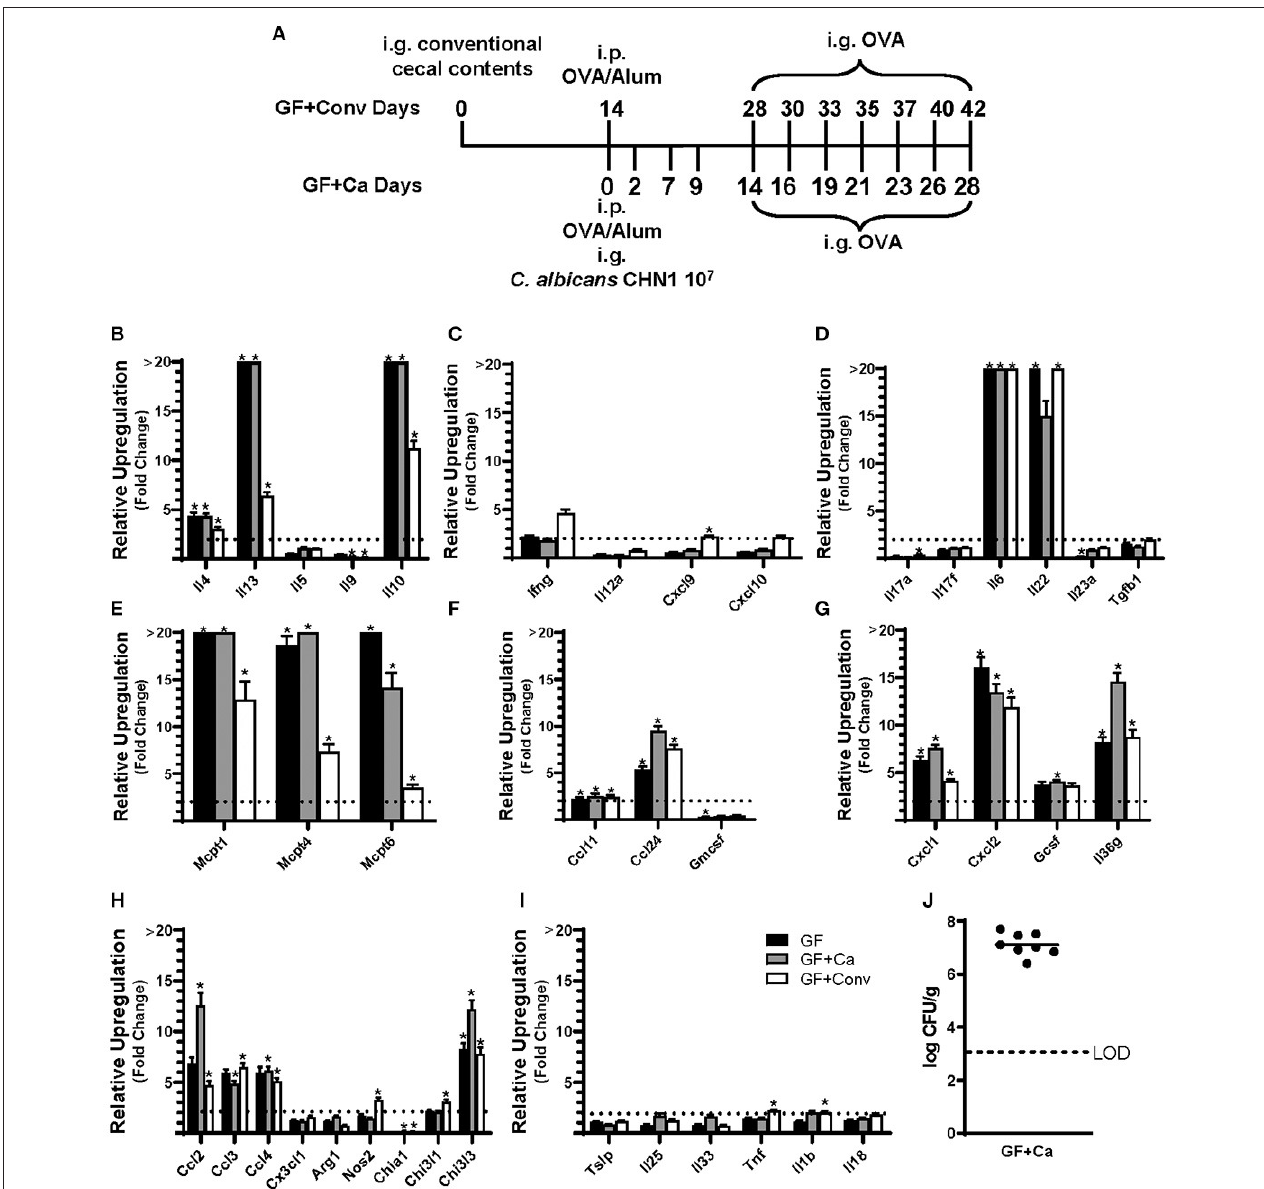
FIGURE 4 | Experimental model and relative expression of cytokine genes in the ileum after OVA sensitization and challenge (D28 GF and GF + Ca or D42 GF + Conv) of three different groups of Balb/cJ mice: germ free (GF), mice monocolonized with Candida albicans CHN1 (GF + Ca), and mice conventionalized with cecal contents from Conv donor mice (GF + Conv). (A) The same model as described in Figure 1A was used in GF mice, GF + Conv, and GF + Ca. GF + Conv mice were orally gavaged with conventional cecal contents from Conv mice 2 weeks prior to food allergy sensitization. Fecal samples were collected from GF + Ca mice at days 2, 7, 9, 14, 19, 23, and 28. (B-I) Mice were treated as outlined in panel A where GF mice were treated like the GF + Ca except the i.g. of C. albicans CHN1. Gene expression was measured by qPCR and is shown as relative expression compared to naïve strain-matched mice. The dotted line indicates a two-fold upregulation from baseline expression levels. Statistical significance (* P < 0.05) signifies significant upregulation in the treated compared to the naïve group for each gene (treated, n = 7-10, naïve, n = 5). Data are plotted as the mean ± SEM. (J) CFU of C. albicans from the cecal contents. Detailed description of analyses and statistical tests used can be found in the Materials and Methods. LOD is the limit of detection. Definitions of gene abbreviations can be found in Table 1 .